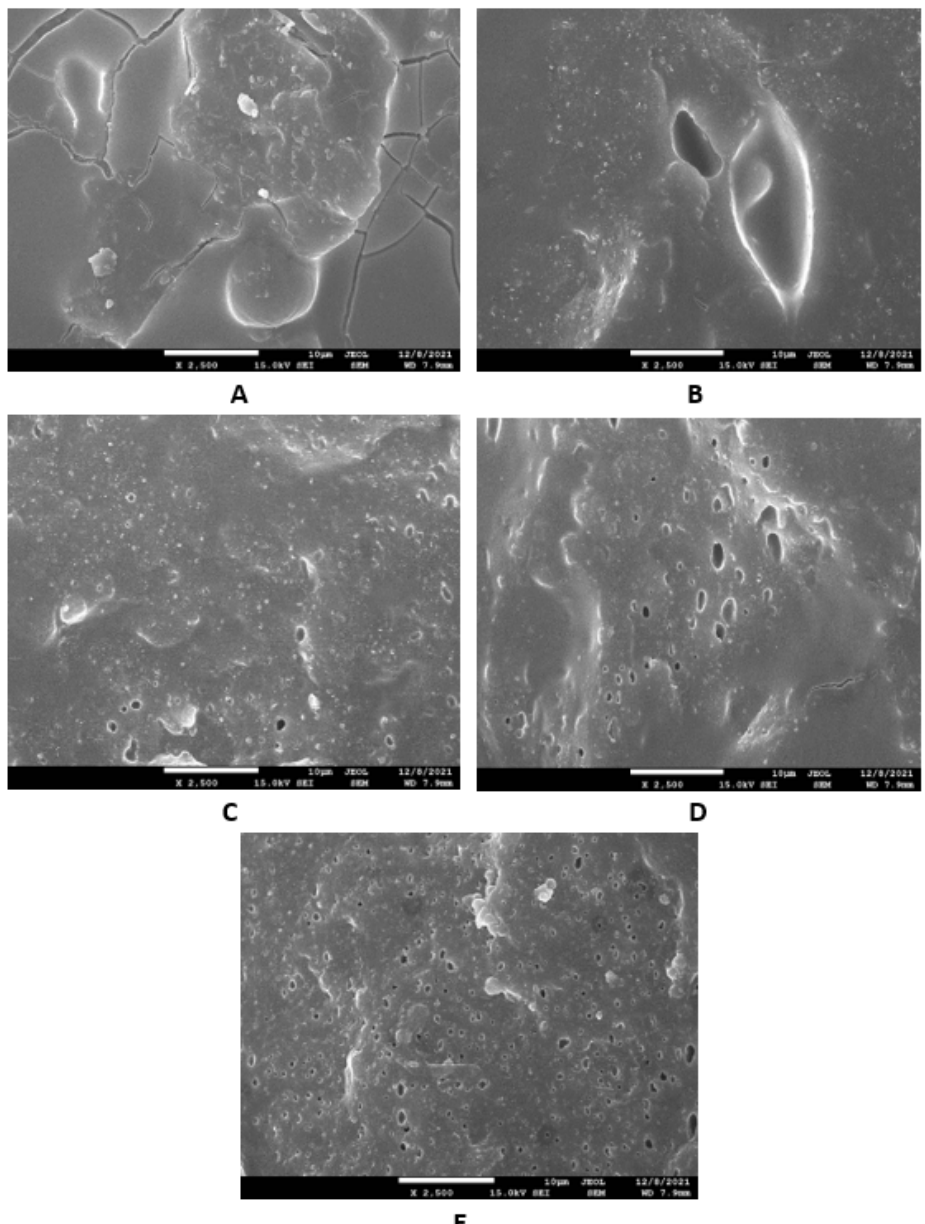
Figure 19. SEM images of vulcanizates NBR/CB-L30: ( A ) reference vulcanizate without glycerol, ( B ) vulcanizate with 5 phr of glycerol, ( C ) vulcanizate with 10 phr of glycerol, ( D ) vulcanizate with 15 phr of glycerol and ( E ) vulcanizate with 20 phr of